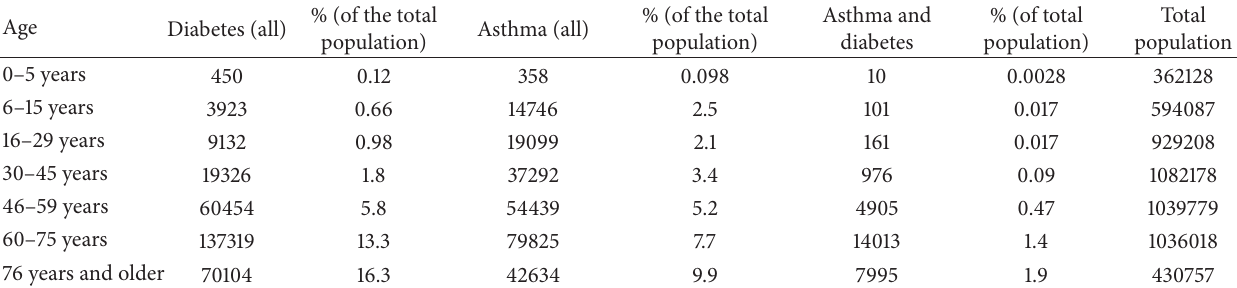
Table 2: Distribution of asthma and diabetes patients in the total population in 2014.